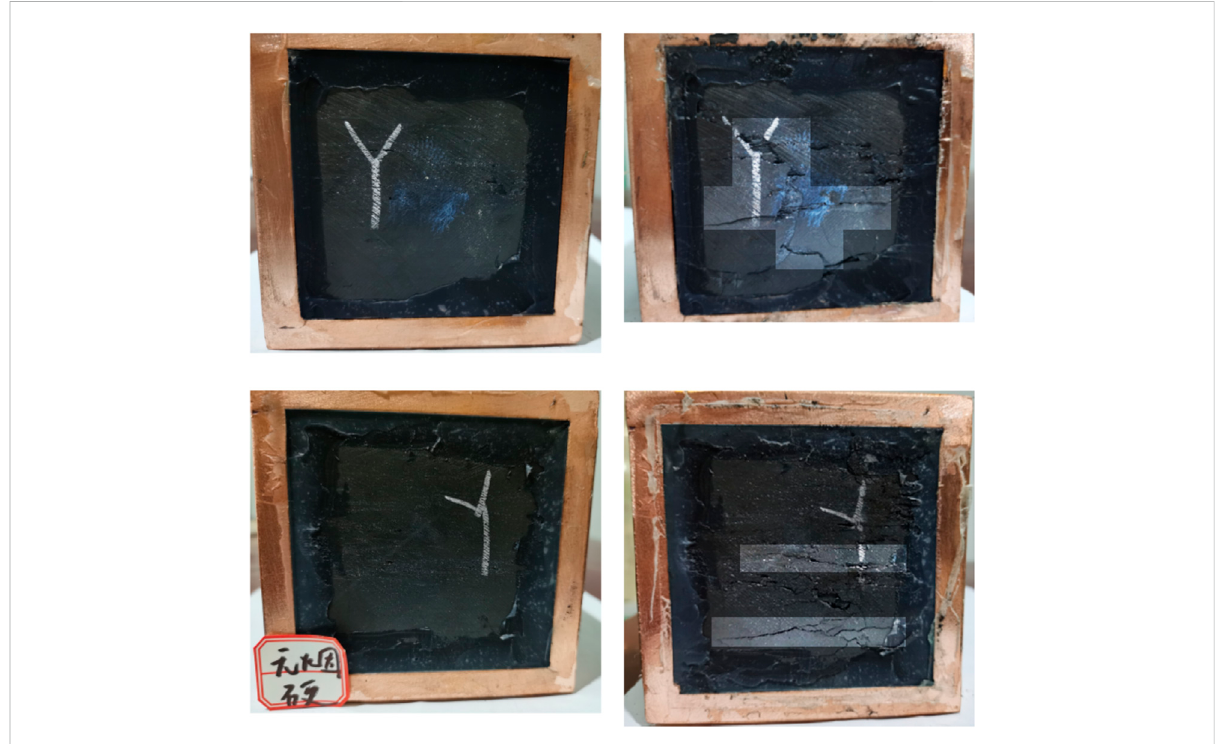
FIGURE 5 Comparison of the Y plane before (left) and after (right) the experiment. Note: The fractures are highlighted with transparent frames. Fracture system perpendicular to the bedding plane and parallel to the bedding plane were